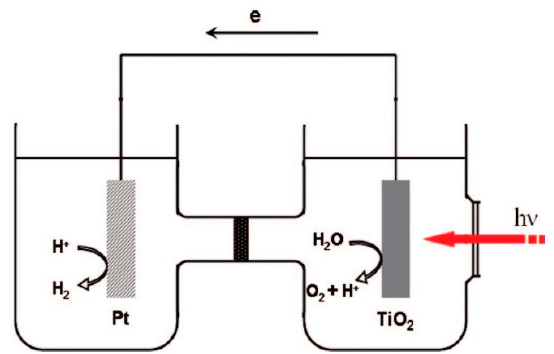
Figure 1. Schematic of a photoelectrochemical cell (PEC). Reproduced with permission from Reference [26]; copyright (1972), Nature Publishing Group.